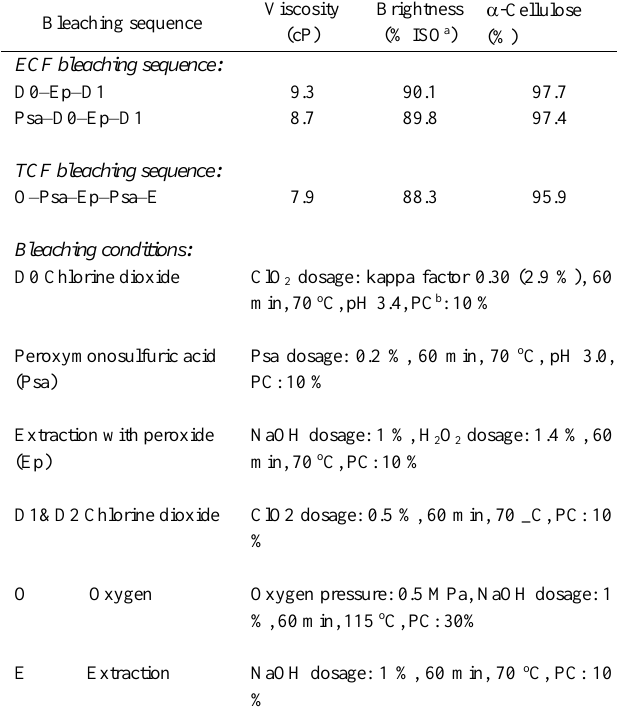
Table 3. Viscosity, brightness, and α-cellulose of bleached pulp